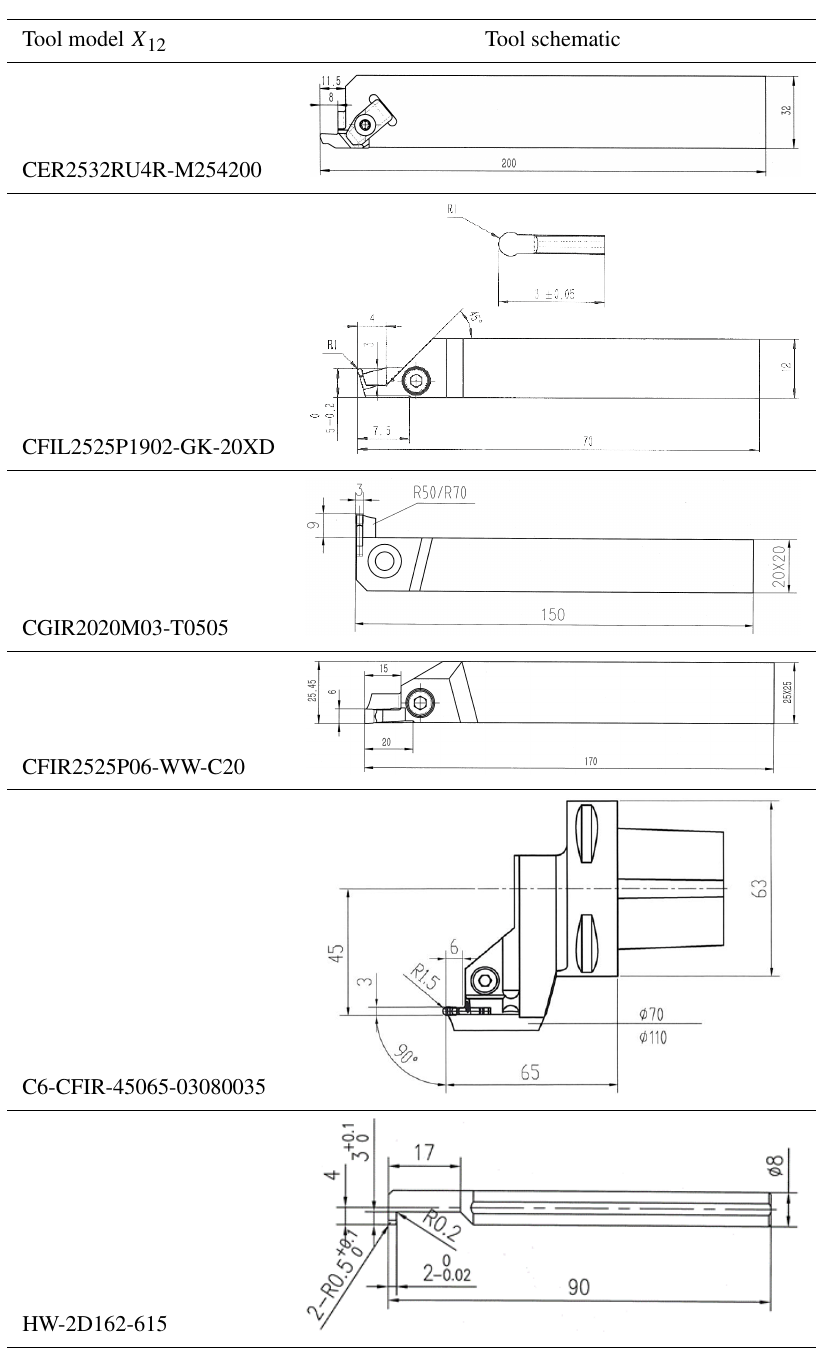
Table A2. Sample tool data